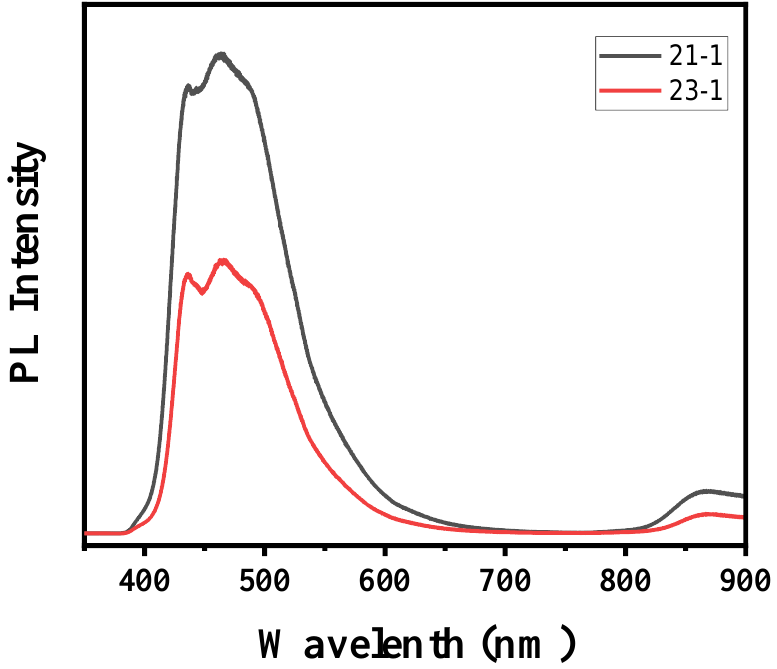
Figure 5. Photoluminescence (PL) spectra of 23 belongs to 0.4 g C 3 N 4 /ZnO; and spectra 21 belongs to 0.3 g C 3 N 4 /ZnO at λ = 510 nm excitation wavelength.